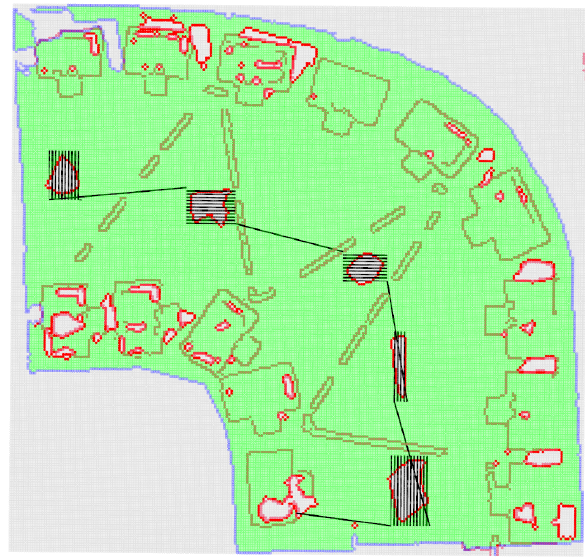
Figure 6. Example of a global path starting from the actual position of the UAS and connection all local paths over each